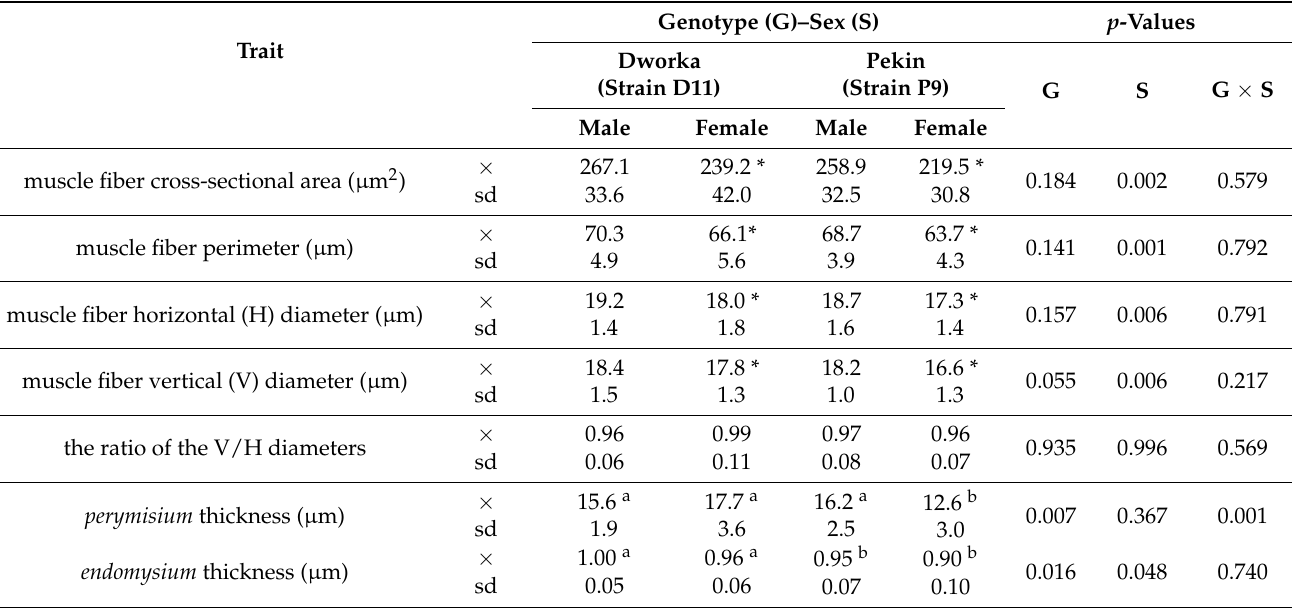
Table 5. Mean values ( × ) and standard deviation (sd) of the microstructure elements of the greater pectoral muscle of 113-week-old